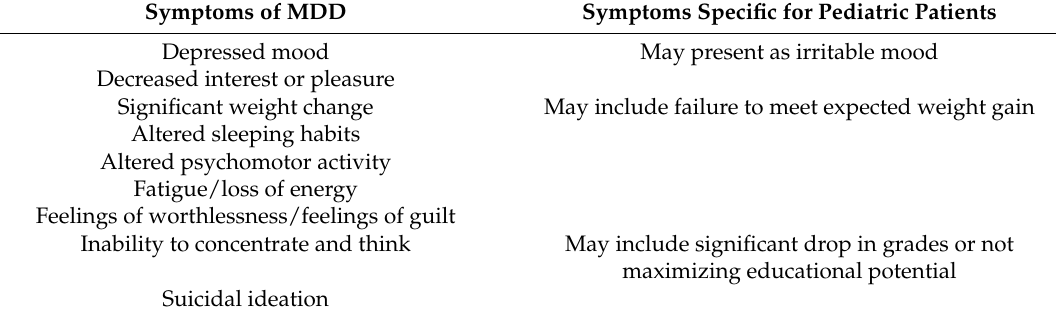
Table 1. Symptoms for the Diagnosis of Major Depressive Disorder (MDD). There are nine main categories of symptoms that are used for the diagnosis of MDD (column 1) and some qualifications that are specific to pediatric patients (column